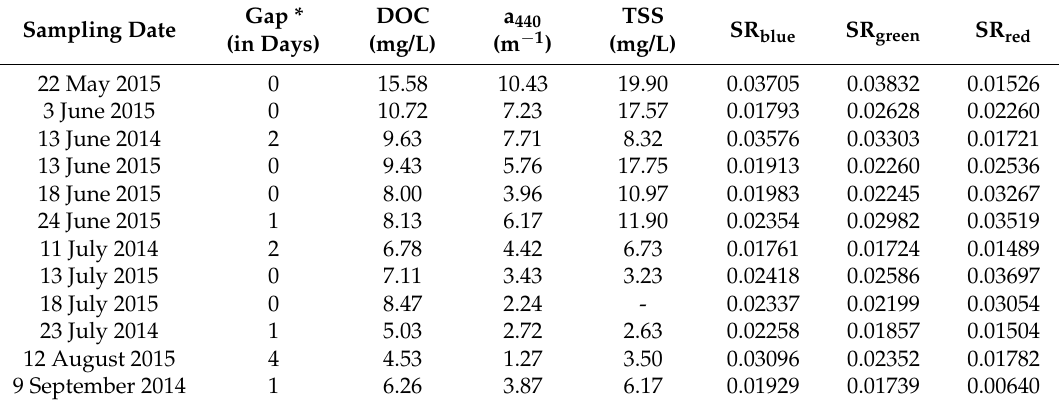
Table 3. DOC concentrations, CDOM absorption, TSS concentrations, and surface reflectances (SR) at the field sample location.